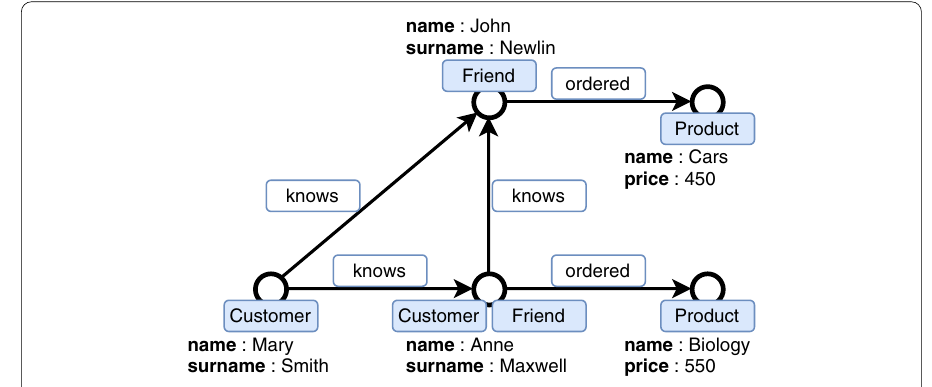
Fig. 18 The result of the query represented in a graph